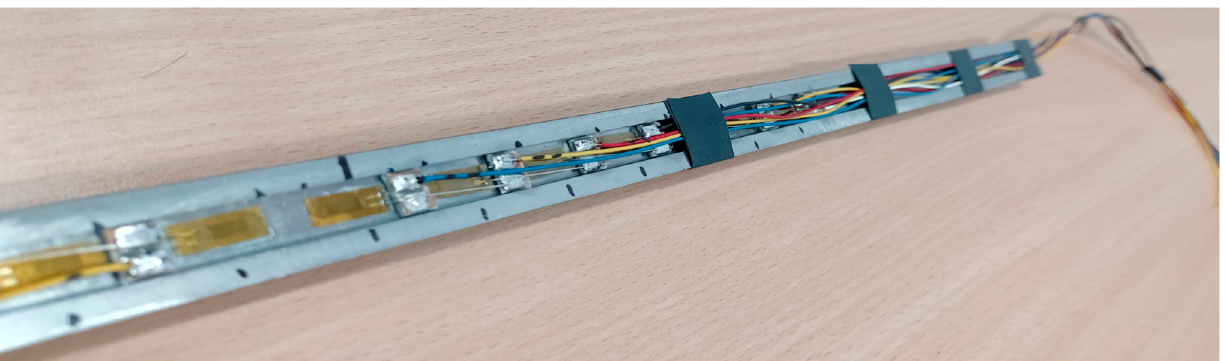
Figure 2. Wiring of strain gauge sensors inside the groove.